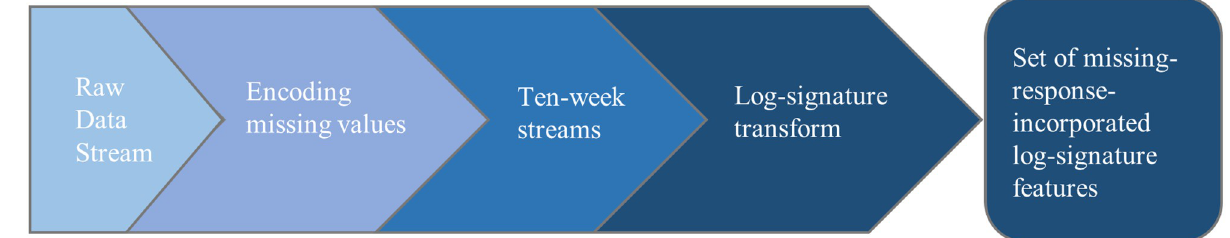
Fig 3. The workflow of feature